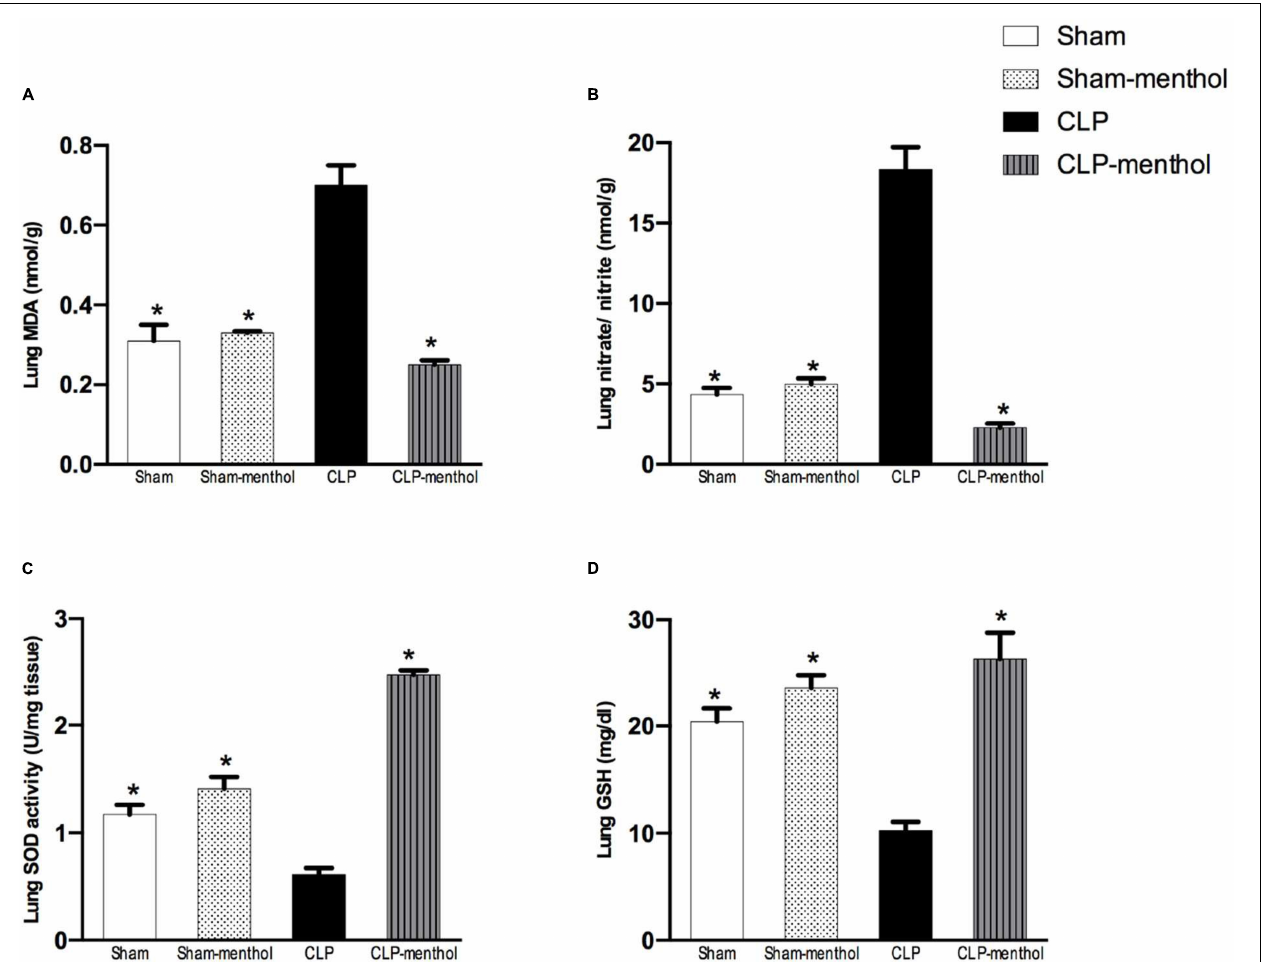
FIGURE 4 | Menthol treatment improves pulmonary oxidative stress status and inhibits the sepsis-induced reduction of the antioxidant capacity of lung tissue. Menthol treatment of CLP rats ameliorated CLP-induced oxidative imbalance in lung tissues as shown with the results of (A) , malondialdehyde (MDA), (B) nitrate/nitrite, (C) activity of superoxide dismutase (SOD) and (D) , reduced glutathione (GSH). Menthol (100 mg/kg, p.o), 2 h after surgery. n = 6 per group. Data were analyzed by one-way ANOVA followed by Tukey’s post-test for multiple comparison. Data represent the mean ± SEM of 6 independent observations. *Significantly different from the CLP group at p <